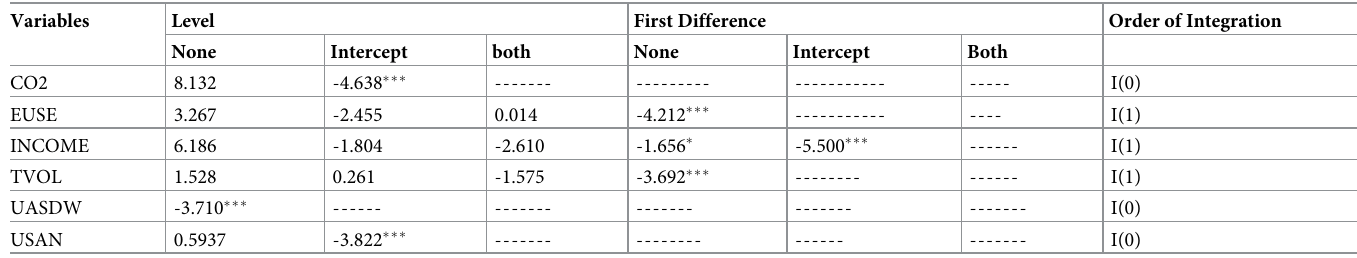
Table 4. ADF unit root estimates.